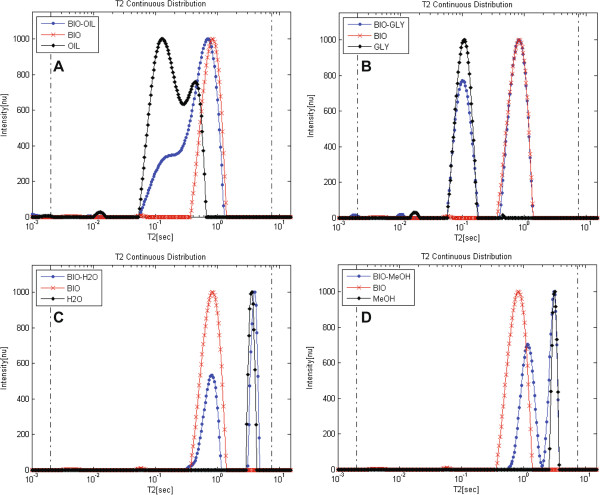
1D continuous distribution of exponentials of biodiesel mixture samples. Relaxation time distributions are shown for biodiesel and (A) oil (BIO-OIL), (B) glycerol (BIO-GLY), (C) water (BIO-H2O) and (D) methanol (BIO-MeOH) mixtures. Relaxation time distributions were calculated using the WinDXP ILT software package. The relaxation time distributions of the pure materials are shown for reference. The position of the different peaks in (A)-(C) is constant also for composite samples, though the peaks in the BIO-OIL mixture are difficult to resolve because of overlapping of components and widening of peaks imposed partly by the WinDXP ILT algorithm. In (D) the position of the biodiesel peak is shifted toward the methanol probably because of solubility interactions between these two components.